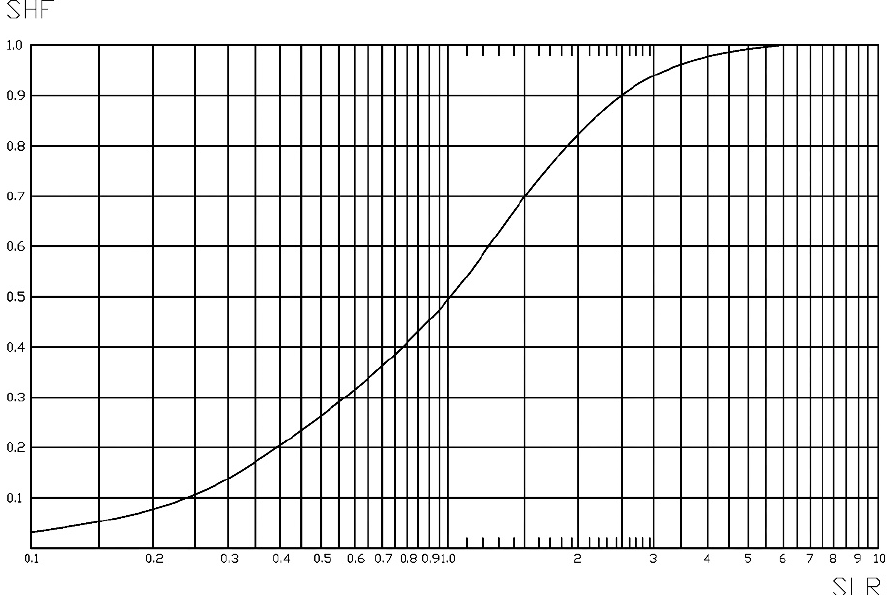
Figure A1. Functional relationships between solar heating rate SHF and solar heat load. (Date Source: [40]). Table A1. Meanings for each character in Equations (MJ).